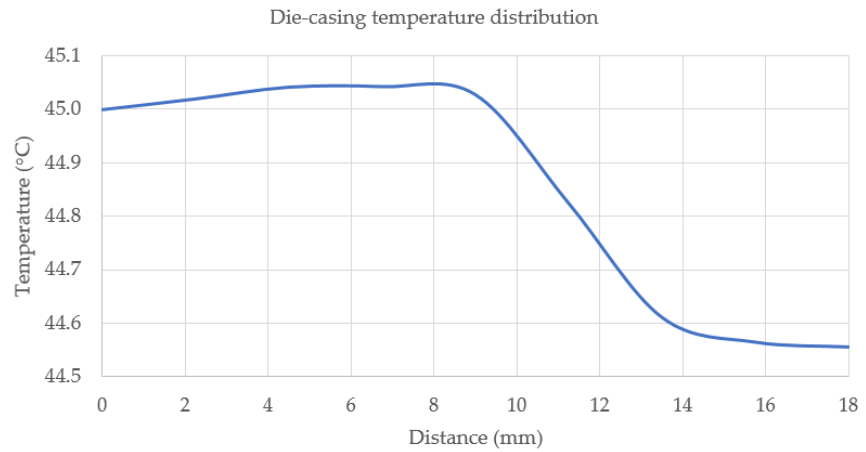
Figure 7. Results of the simulations carried out the temperature on the path between the die of the semiconductor diode and the point of the housing, the temperature of which is closest to the die temperature. The result obtained for Pj = 5.48 W.